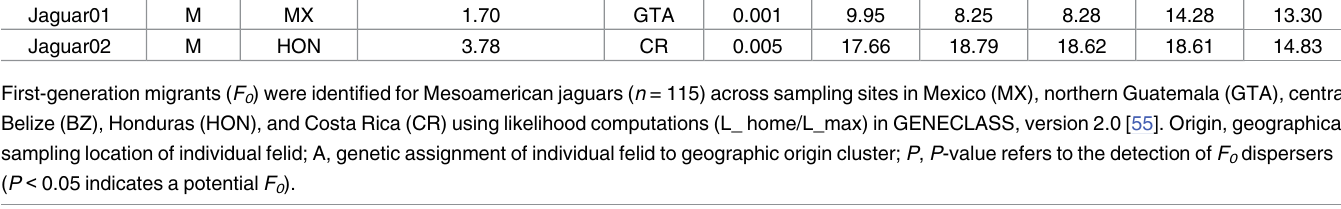
Belize (BZ), Honduras (HON), and Costa Rica (CR) using likelihoodcomputations (L_ home/L_max) in GENECLASS, version 2.0 [55]. Origin, geographical sampling location of individual felid; A, genetic assignment of individualfelid to geographic origin cluster; P , P -value refers to the detection of F 0 dispersers ( P < 0.05 indicates a potential F 0 ).